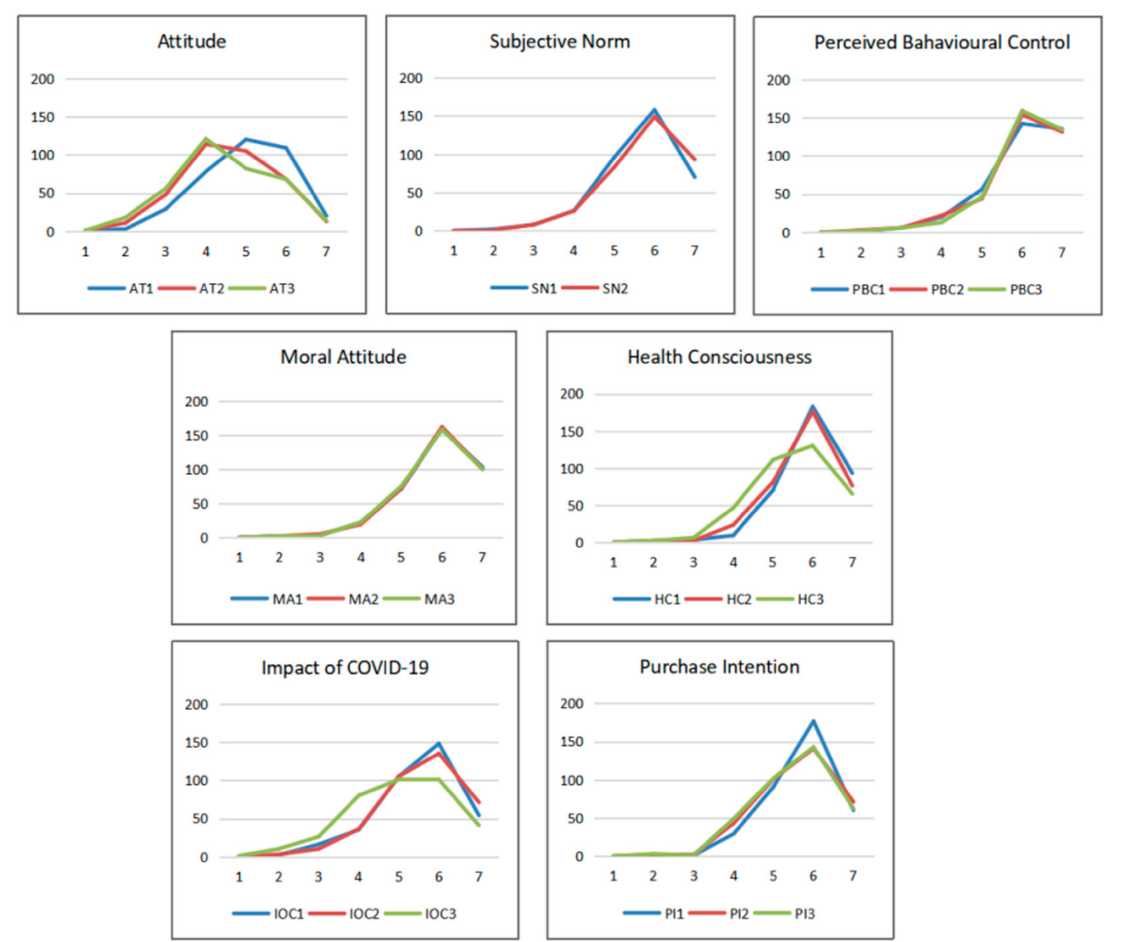
Figure 2. The overview of responses ( n = 360): X-axis, seven-point scale (1 = strongly disagree, 2 = disagree, 3 = somewhat disagree, 4 = neither agree nor disagree, 5 = somewhat agree, 6 = agree, 7 = strongly agree); Y-axis, number of responses; AT, attitude; SN, subjective norm; PBC, perceived behavioural control; MA, moral attitude; HC, health consciousness; IOC, impact of COVID-19; PI, purchase